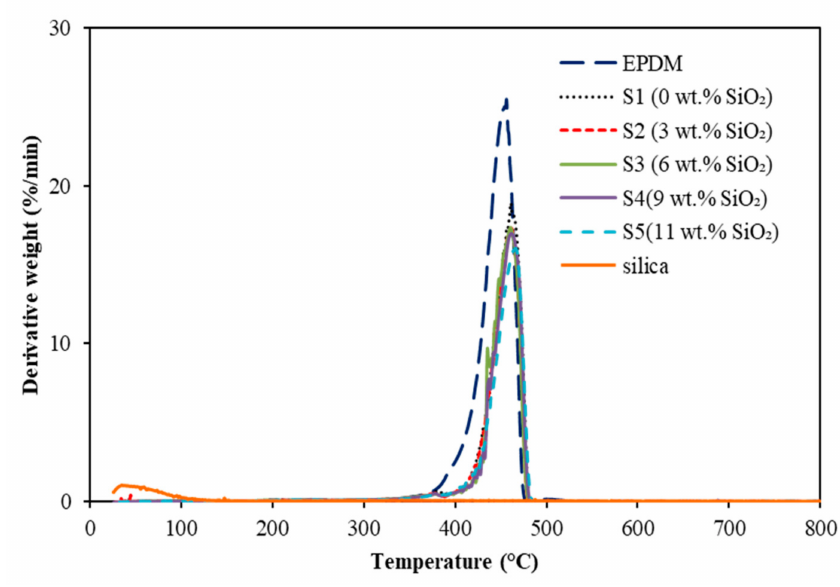
Figure 4. DTG curves of EPDM, silica and EPDM-based MREs with different contents of silica.